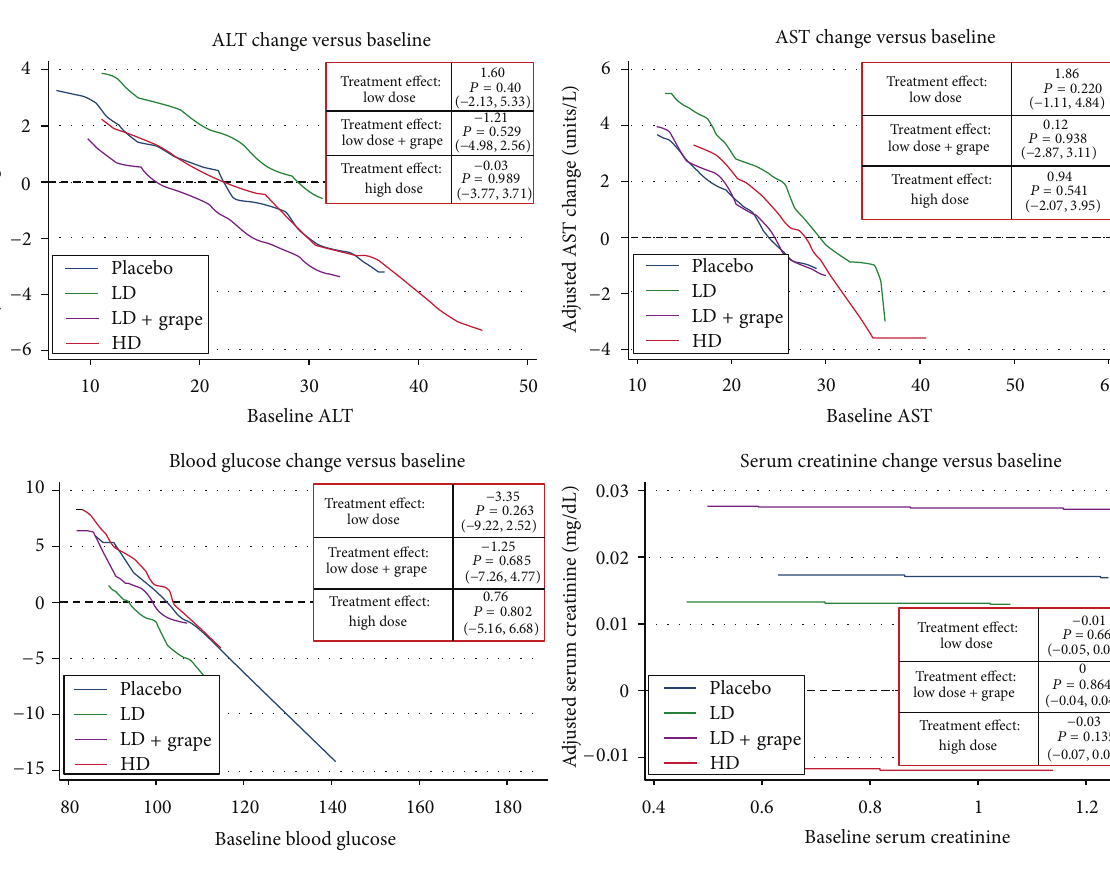
Figure 1: Primary safety analysis. Interpretation: expected Changes in an Outcome (vertical axis) for any given level of baseline value (horizontal axis) across all four treatment groups. Adjusted for age, gender, and